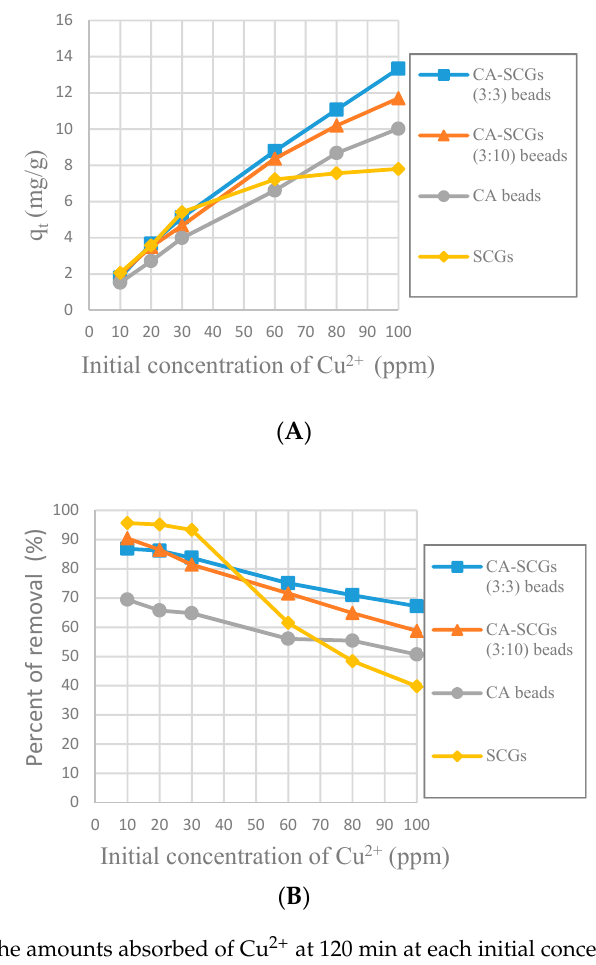
Figure 11. Plots of the amounts absorbed of Cu 2+ at 120 min at each initial concentration of Cu 2+ , ( A ): Experimental amounts of Cu 2+ adsorbed at 120 min (q t ); ( B ): Percentages of removal at 120 min (%).